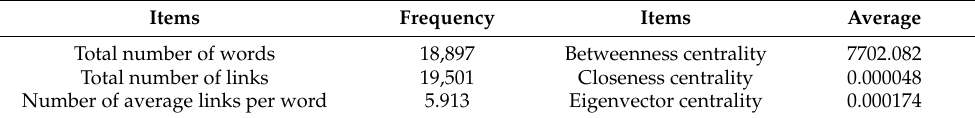
Table 3. Indices for the analysis results of the language network of victims’ families.